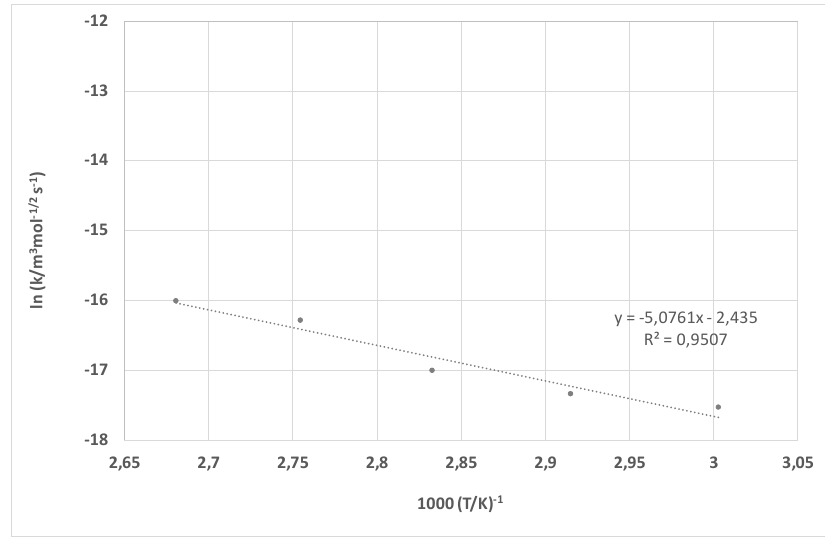
Figure 9. The Arrhenius plot for experiments in the 1.5 mol cm − 3 NaOH solution.